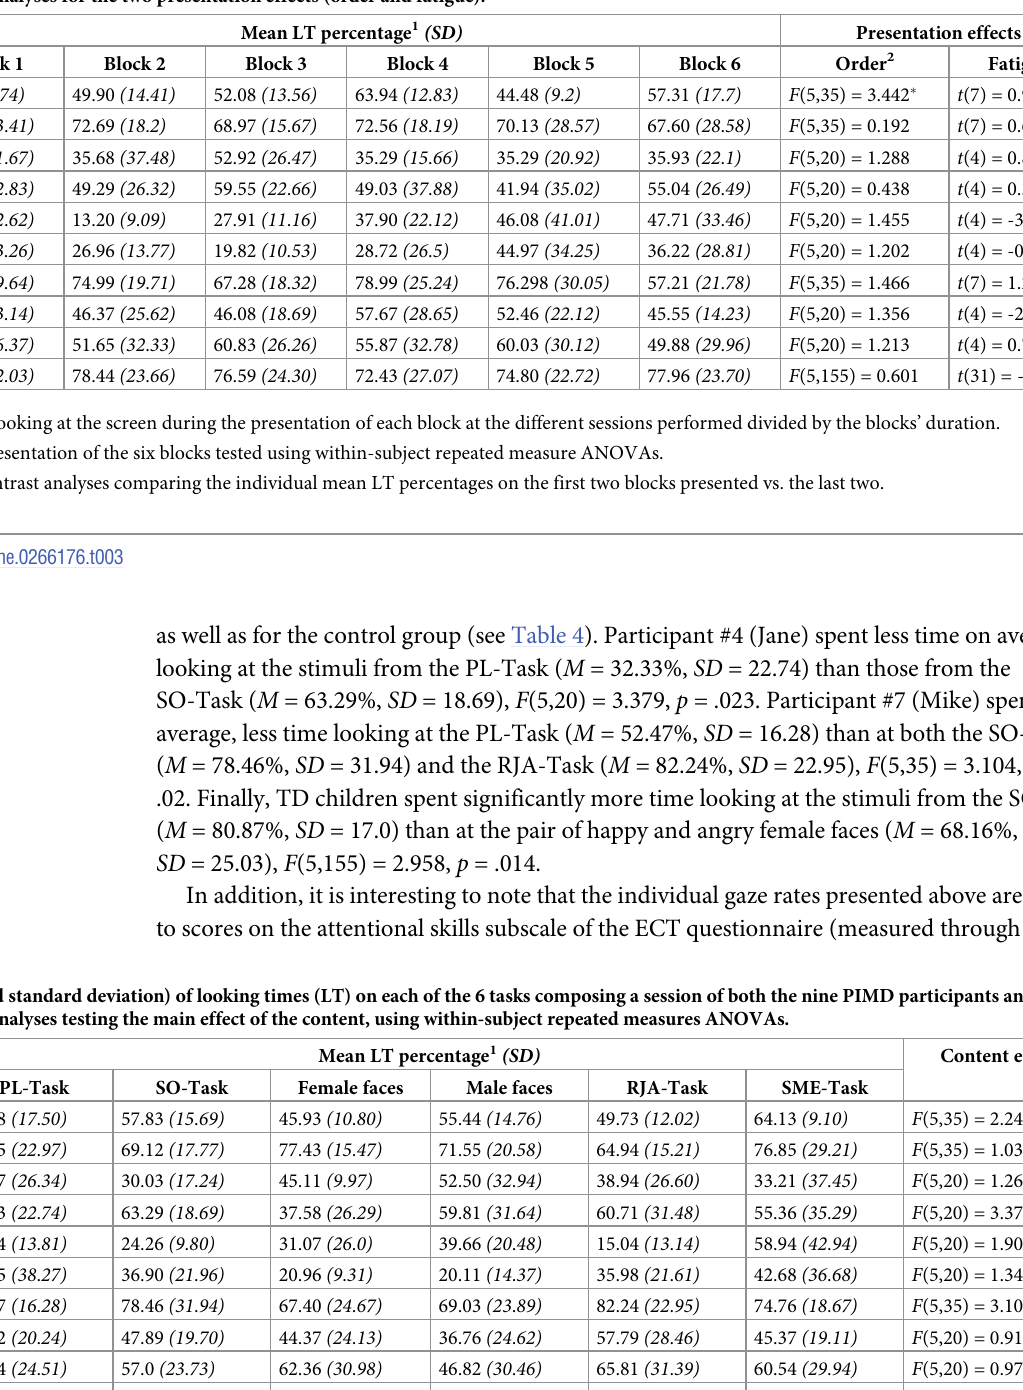
Table 3. Mean percentage (and standard deviation) of looking times (LT) at each of the 6 blocks composing a session of both the nine PIMD participants and the control group, and statistical analyses for the two presentation effects (order and fatigue). Participant